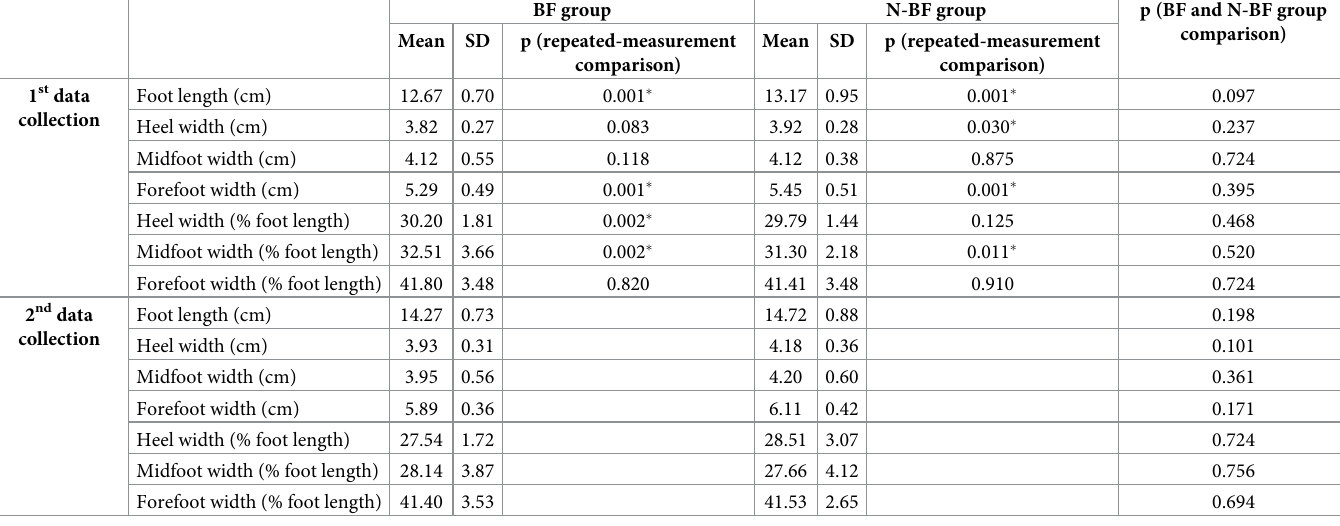
Table 3. Dynamic foot anthropometry results of comparison between data collection sessions and between groups.